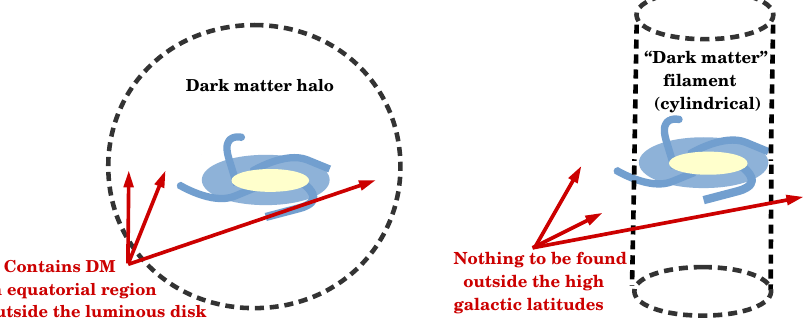
Figure 2. ( Left ): A spherical halo of dark matter extending much beyond the disk of spiral galaxies. The radial dependence of that mass distribution that yields a flat rotation curve is the quite unique ρ DM ∝ r − 2 . This can be obtained from hydrostatic equilibrium with an isothermal distribution, but requires that dark matter is thermalized, involving some heat transfer mechanism (at odds with dark matter particles being very weakly interacting). ( Right ): A cylindrical distribution extending from the galactic polar regions explains flat rotation curves without any fine tuning: they are the natural consequence of such gravitational source independently of its nature (whether dark matter or otherwise) without having to abandon Newtonian mechanics for MOND or other